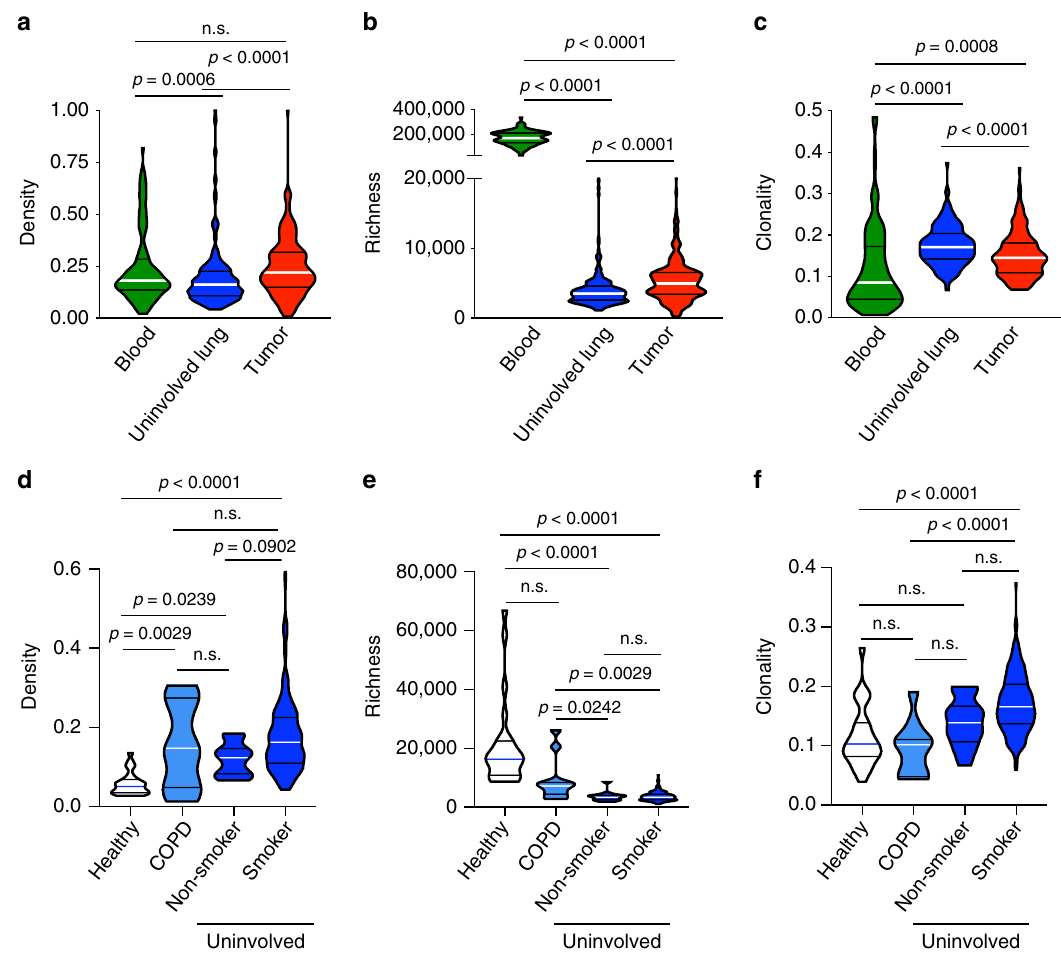
Fig. 5 T cell clonality is increased in the tumor-adjacent lung. a T cell density, ( b ) richness, and ( c ) clonality in the peripheral blood (green, n = 121), uninvolved tumor-adjacent lung (blue, n = 216) and tumor (red, n = 225). d T cell density ( n = 253), ( e ) richness ( n = 253), and f clonality ( n = 253) in healthy (white), COPD (light blue), and tumor-adjacent uninvolved lungs (blue) from smokers and non-smokers. Bars represent median and quartiles.